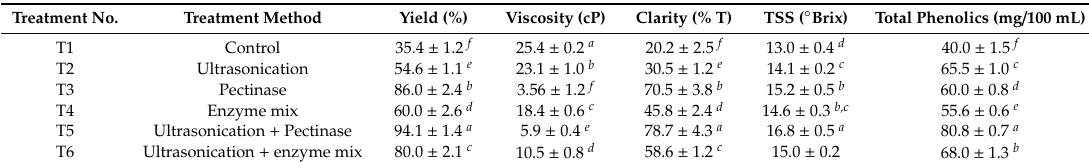
Table 1. E ff ect of ultrasonication and enzyme treatments on the yield and physicochemical properties of Totapuri mango